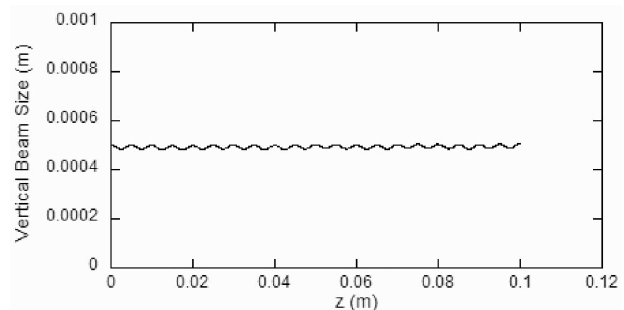
FIG. 5. Natural focusing with both vertical space-charge and emittance effects for PPM focusing. Balanced flow is achieved with a peak field of about 0.2725